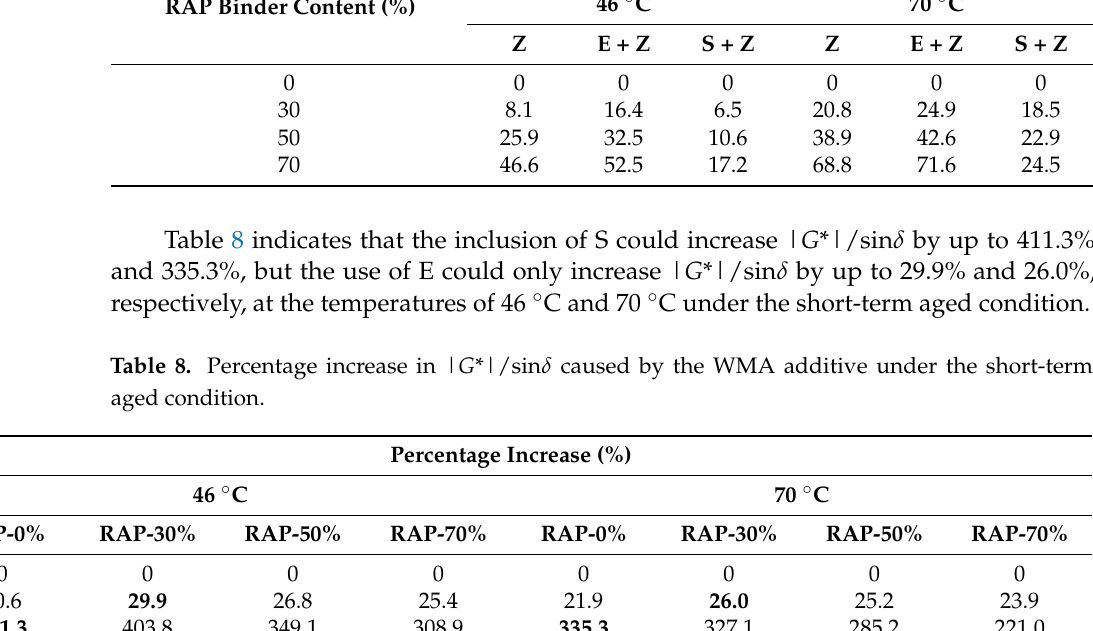
Table 8. Percentage increase in | G *|/sin δ caused by the WMA additive under the short-term aged condition.